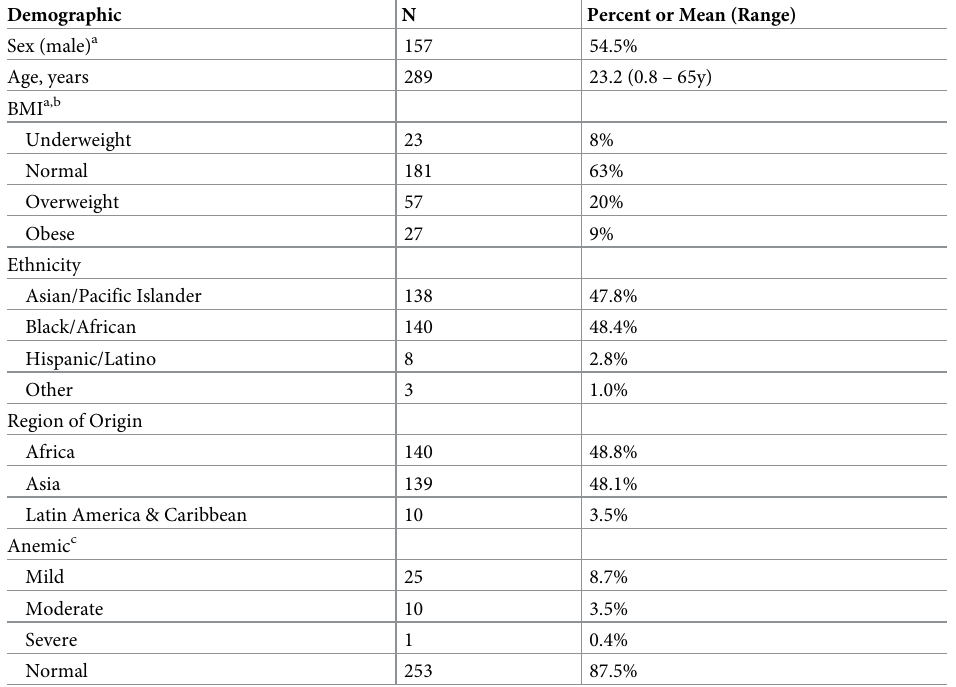
Table 1. Characteristics of participants assessed for hemoglobin concentrations, N =